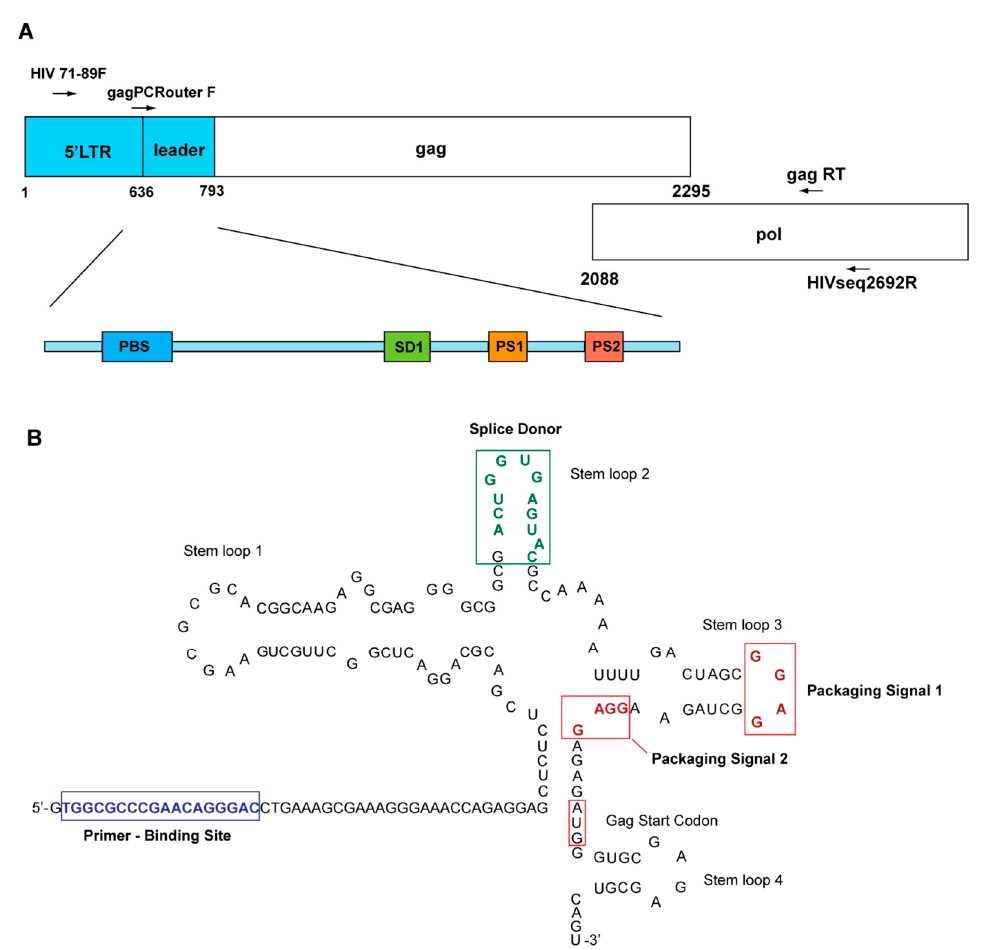
Figure 1. HIV-1 5’LTR leader sequences. ( A ). A schematic sketch of 5’LTR-leader sequence variant positions analyzed in this study; ( B ). a schematic sketch of secondary structure of HIV-1 5’leader sequence.